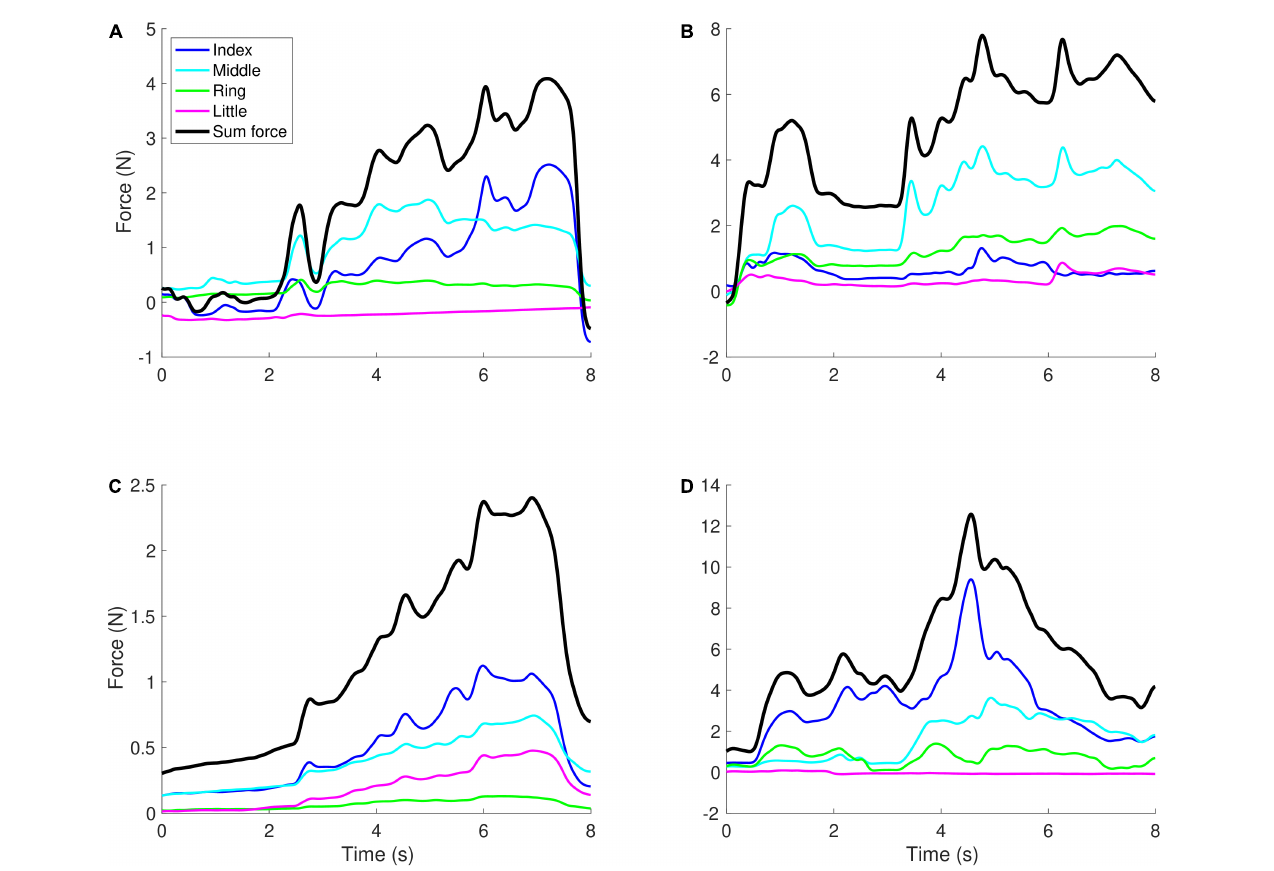
FIGURE3 Examples of force profiles. Each graph shows the forces applied by the four fingers in a single trial, with the black line showing the sum of the forces (which controlled the height of the object on the screen). (A) A younger child (aged 5) with TBI, (cid:49) v = − 0.71, (B) a younger child (aged 5) with CP, (cid:49) v = − 1.57, (C) an older child (aged 12) with TBI, (cid:49) v = − 2.15, (D) an older child (aged 10) with CP, (cid:49) v = − 0.77. When there is more positive covariation between the fingers, i.e., in panels (B,C) , (cid:49) v tends to have lower values (more negative), while when negative covariation is observed, (cid:49) v tends to have higher values, i.e., in panels (A,D)